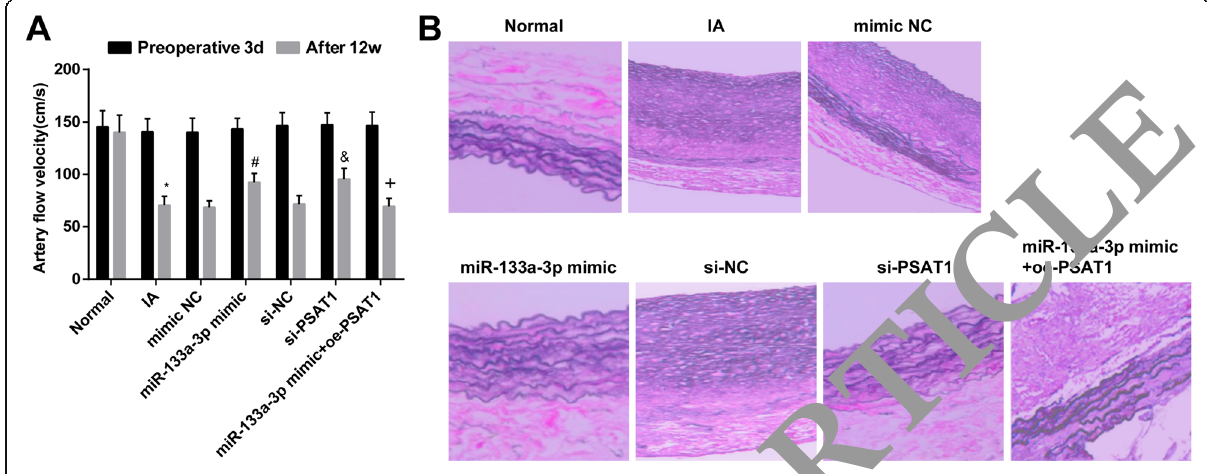
Fig. 6 Upregulated miR-133a-3p and downregulated PSAT1 alleviate the pathological changes of IA tissues. a Hemodynamic changes at each time point after successful modeling in rats. b Changes of IA tissue after transfection. n = 12, * P < 0.05 vs. the normal group. # P < 0.05 vs. the mimic NC group. & P < 0.05 vs. the si-NC group. + P < 0.05 vs. the miR-133a-3p mimic group. Measurement data were depicted as mean ± standard deviation, and data were assessed by one-way analysis of variance followed by Tukey ’ s post hoc